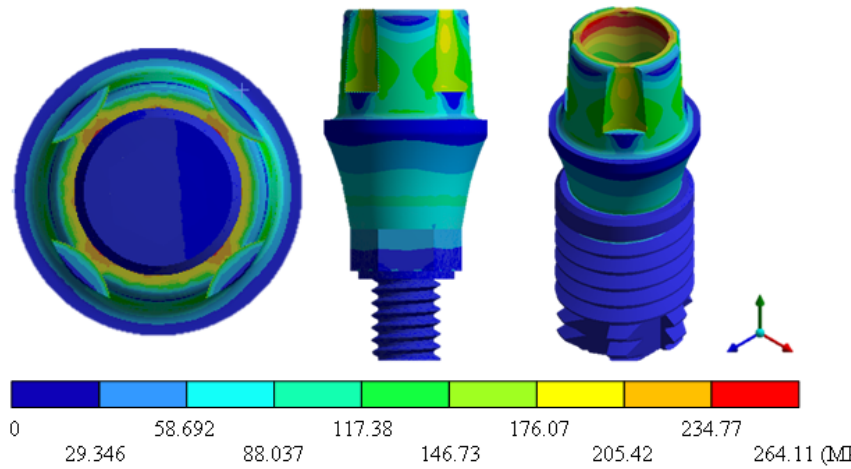
Figure 11. Total general displacement for Snappy type implant (Ti 6 Al 4 V).